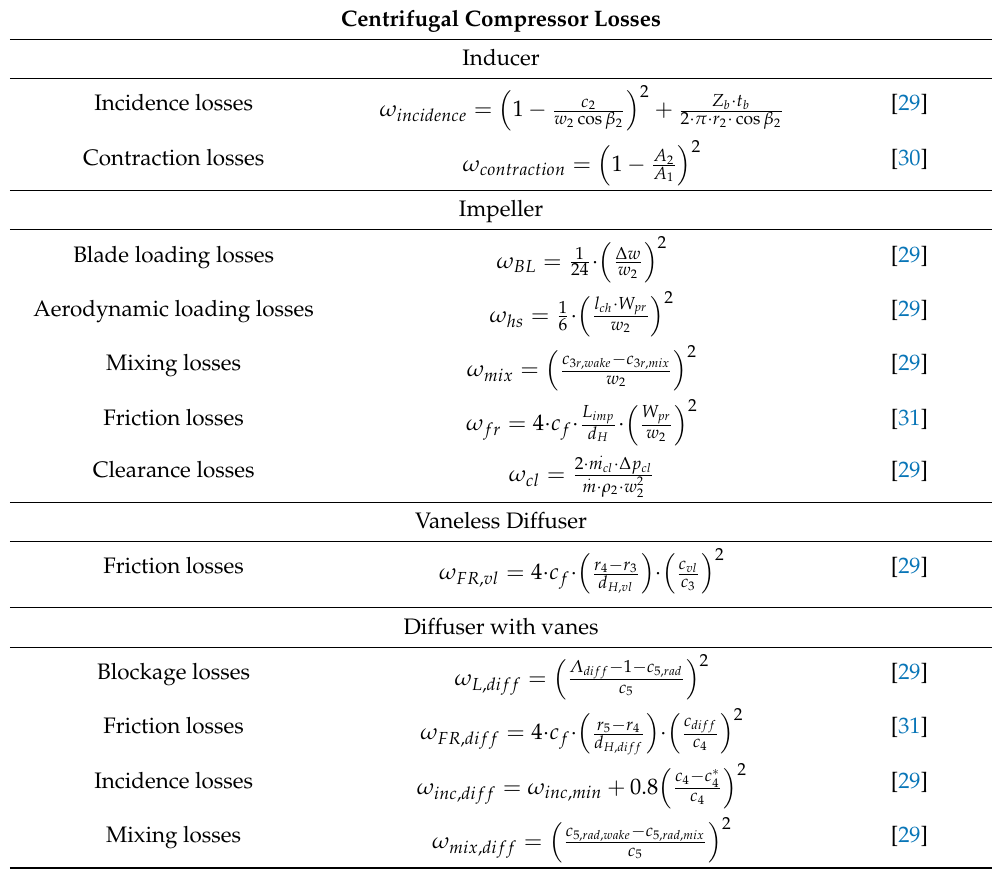
Table 5. Formulas used to estimate pressure loss mechanisms for centrifugal compressor design and related